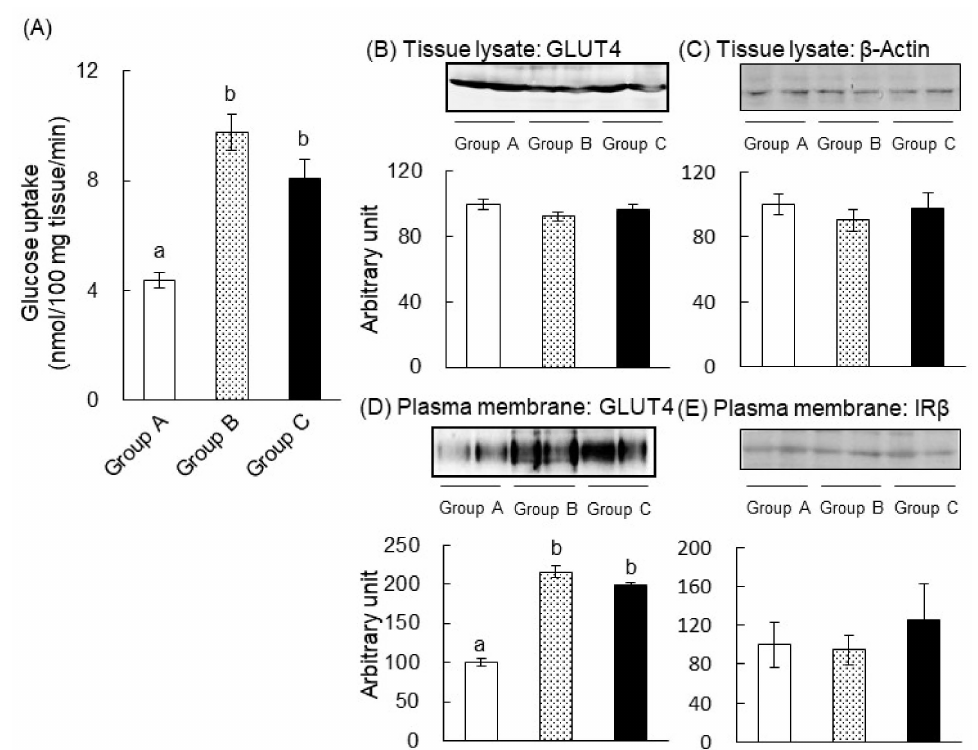
Figure 7. Green tea consumption increased glucose uptake and GLUT4 translocation in the skeletal muscle of KK-A y mice. Mice were treated as shown in Figure 1B. On Day 63, the mice were orally administered glucose (2 g / kg body weight) and were sacrificed 1 h later. ( A ) Skeletal muscle was cut into small pieces of 50 mg each, and 3-OMG uptake was measured as described in “Materials and Methods”. The expressions of GLUT4 and β -actin in tissue lysates ( B , C ) and the quantities of GLUT4 and IR β present in the plasma membrane fractions ( D , E ) were determined through western blot analysis, as described in “Materials and Methods”. In ( B – E ), the upper panels show typical immunoblots and the lower panels summarize the density of each band in all mice ( n = 7). Data are expressed as the means ± SE. Values sharing the same letters were not significantly di ff erent (Tukey–Kramer multiple comparison test; p <